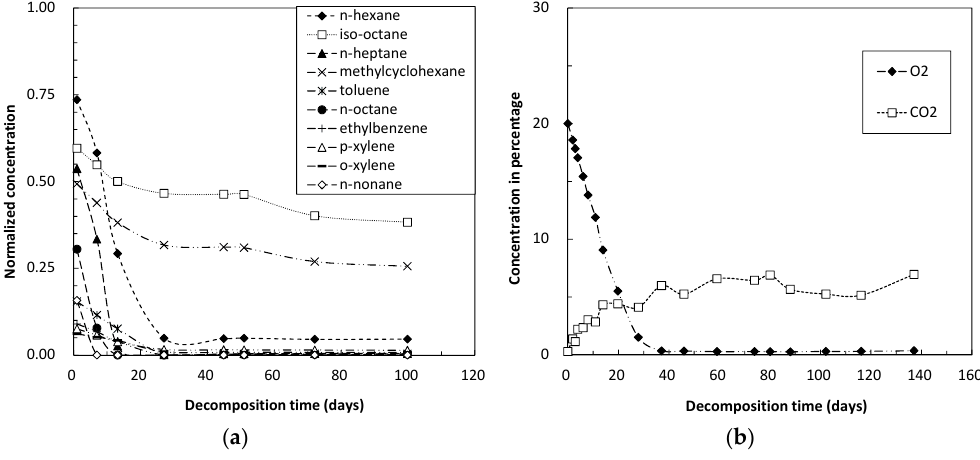
Figure 3. Concentrations over time of ( a ) organic and ( b ) inorganic gases during decomposition tests in subsurface soil.